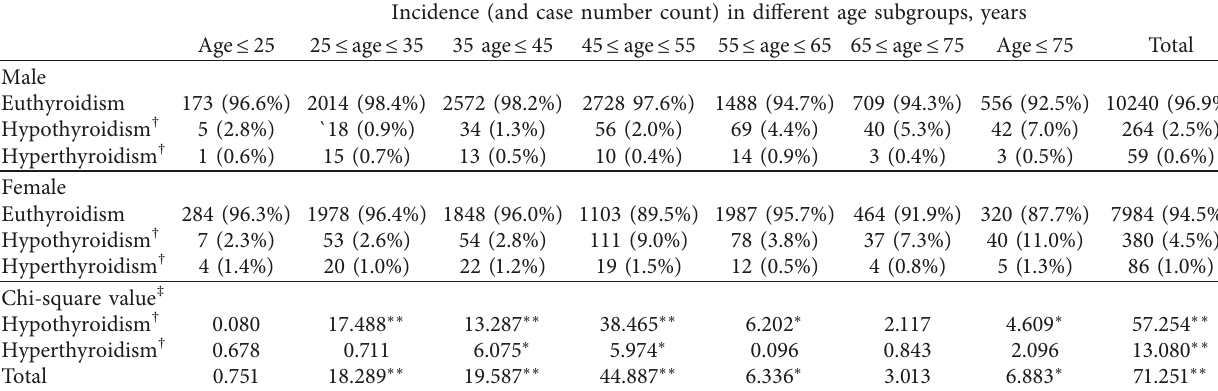
Table 2: Incidence of hypothyroidism and hyperthyroidism on different genders. Incidence (and case number count) in different age subgroups, years